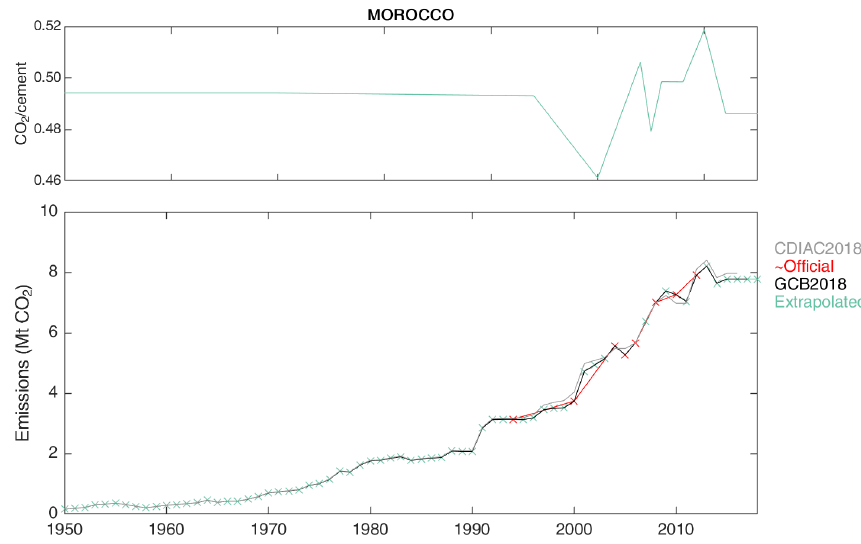
Figure C33. Revised cement emissions for Morocco.